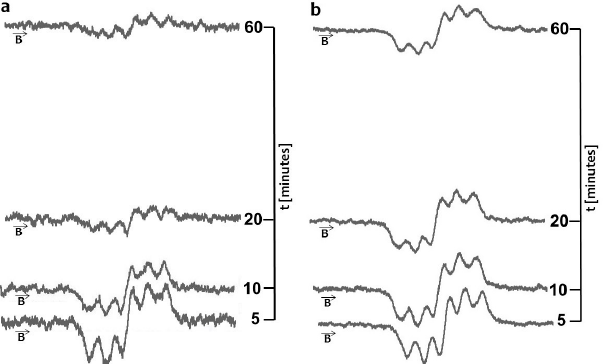
Figure 1. EPR spectra of DPPH interacting with unheated and non-irradiated ( a ) propolis drops; and ( b ) propolis spray for 5 min, 10 min, 20 min, 60 min. B —magnetic induction. The kinetics of DPPH free radicals interactions with unheated and non-irradiated drops and spray containing propolis are shown in Figure 2.